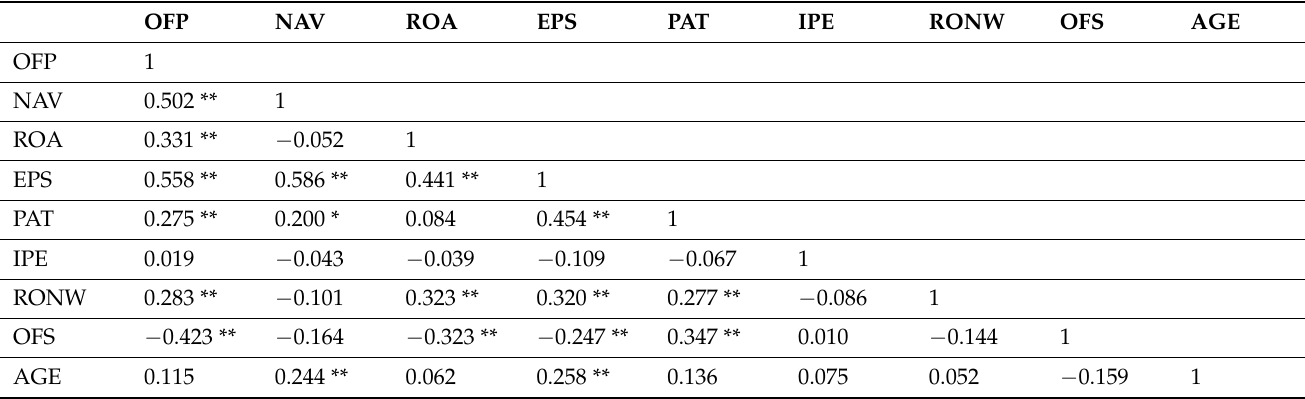
Table 4. Matrix of Bivariate Correlation.